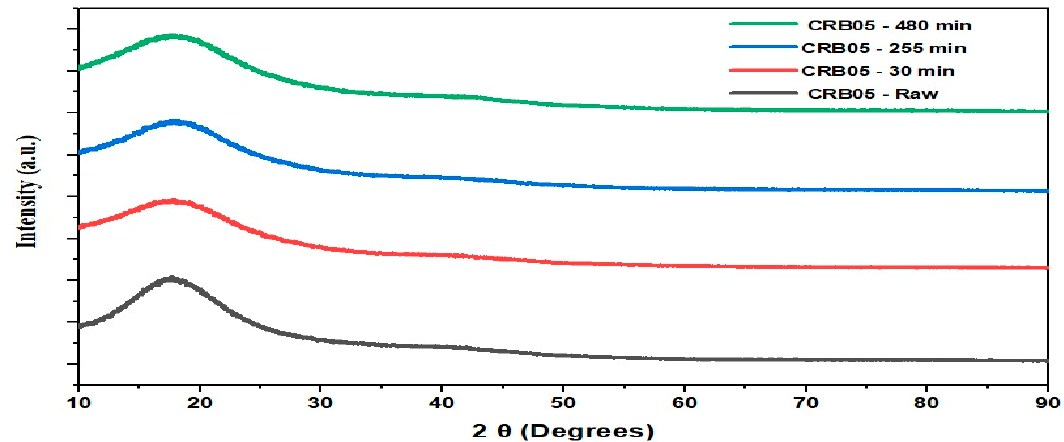
Figure 1. XRD patterns for CRB05 before and after boron removal experiments.